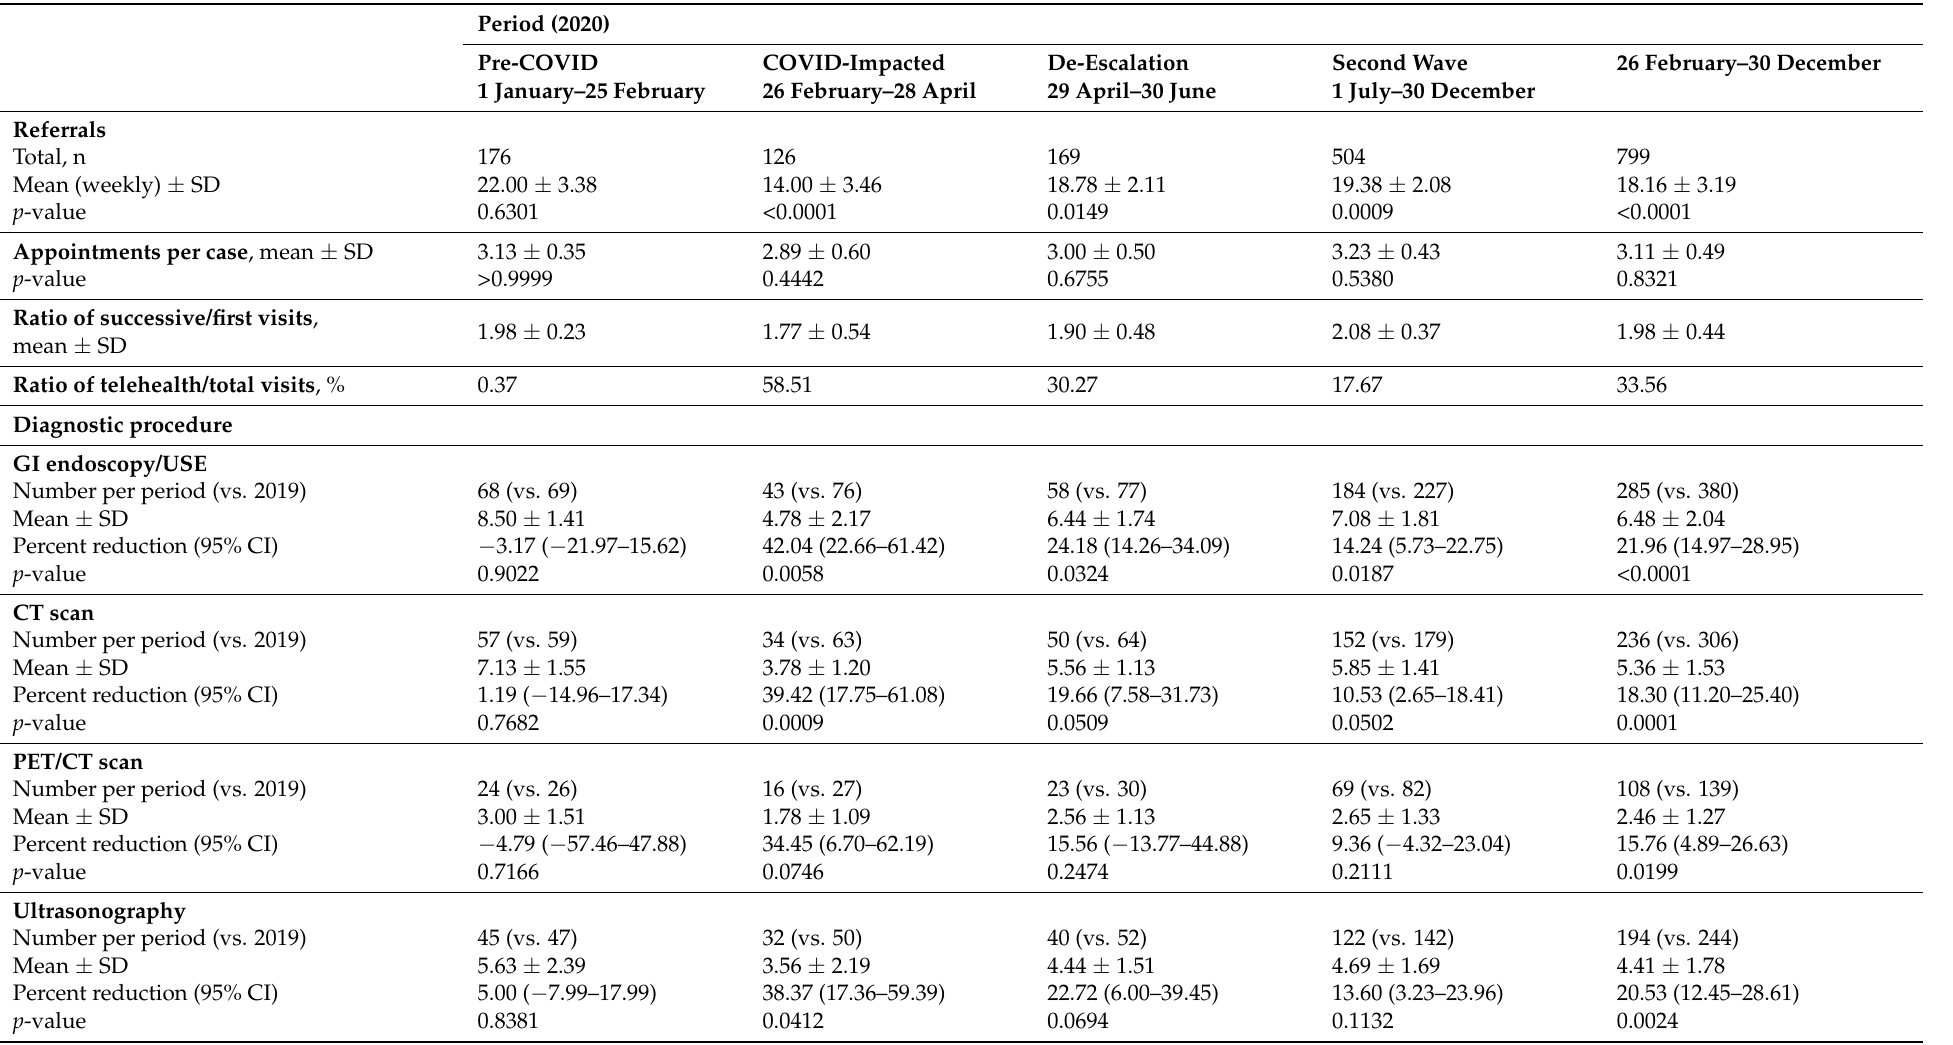
Table 2. Referrals, appointments, and procedure volumes across study periods in